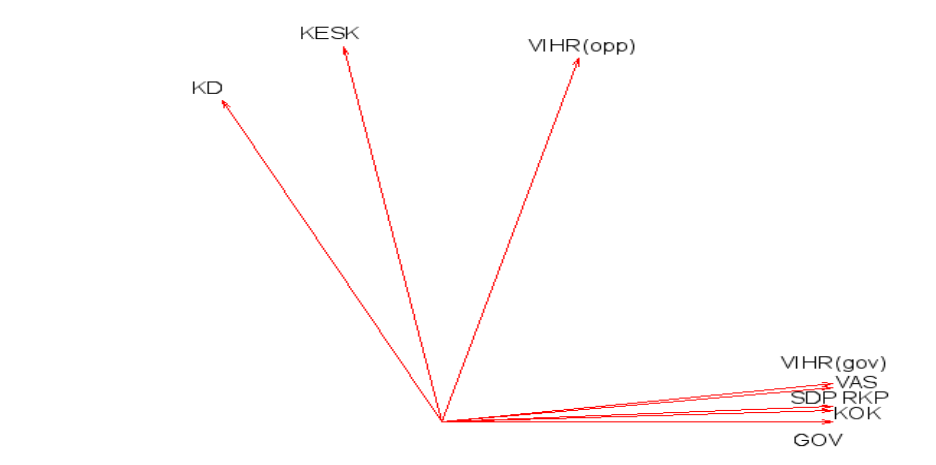
Figure 2c. Government and opposition voting during the Lipponen II government (1999–2002)